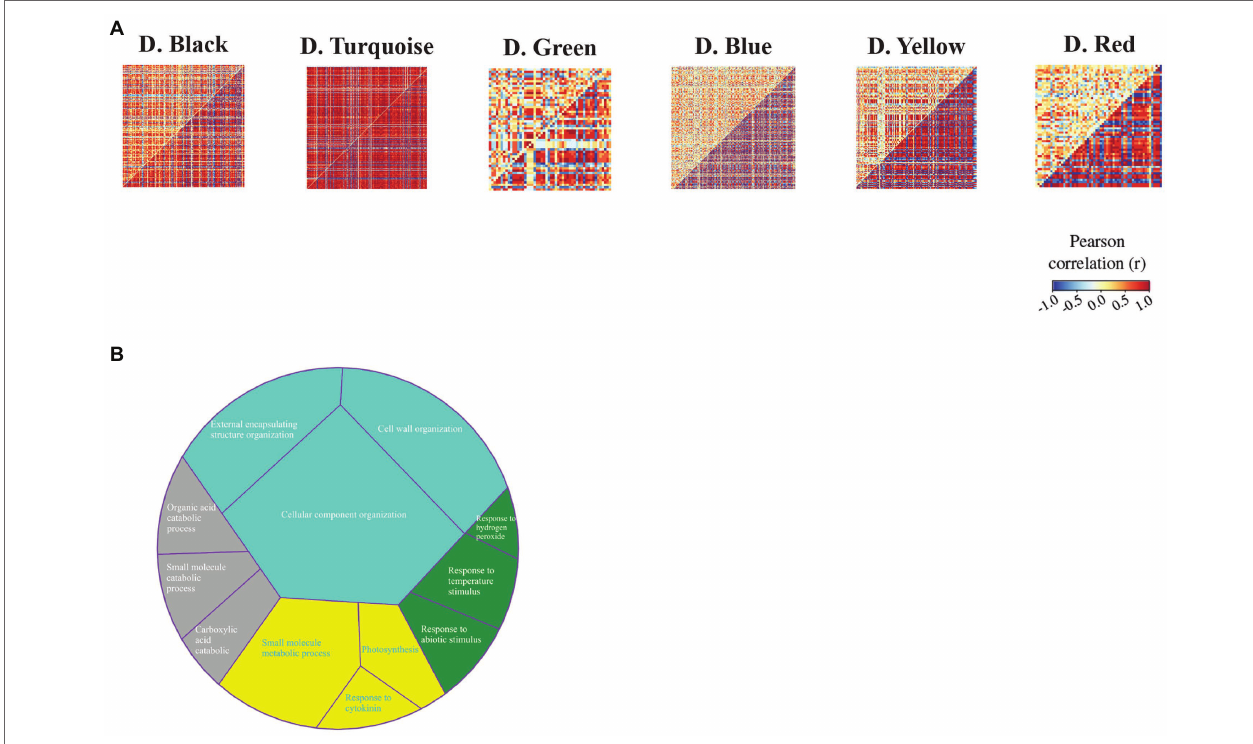
FIGURE 5 | Differential co-expression modules identified between maize ( Z. mays ) and rice ( O. sativa L.). (A) Heat maps display the correlation between all gene pairs contained within each module. The red and blue colors correspond to positive and negative correlations, respectively. (B) GO enrichment analysis of differential co-expression modules. The colors indicate differential co-expression